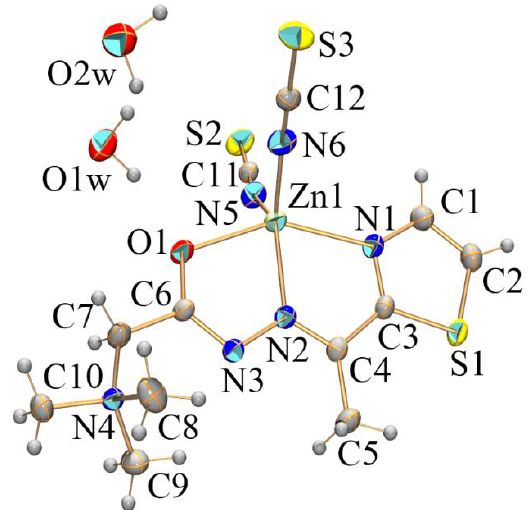
Figure 1. ORTEP presentation of the molecular structure of [Zn L 1 (NCS) 2 ] · 2H 2 O ( 1 ). Thermal ellipsoids are drawn at the 30% probability level.